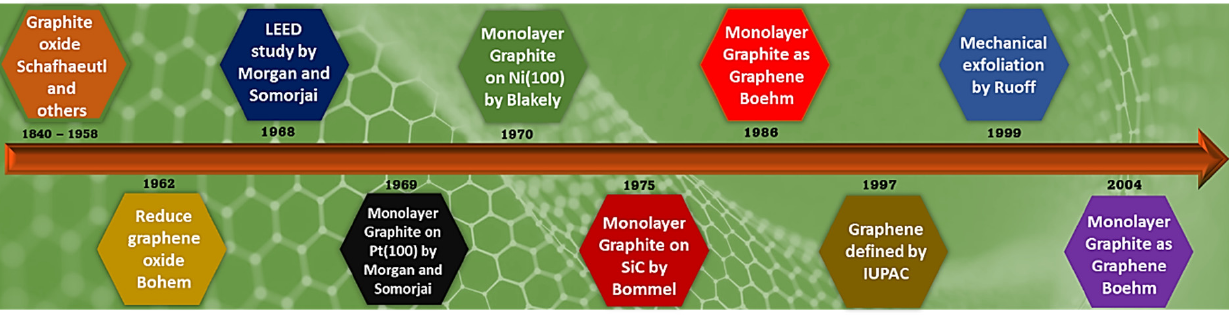
Figure 1. Timeline of historical development of graphene.